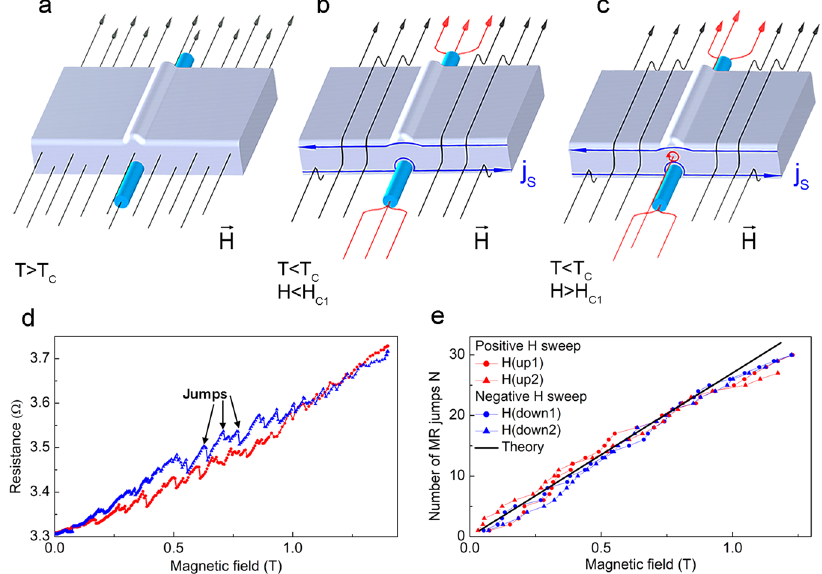
Figure 2. Device behavior at different external magnetic fields and temperatures. ( a ) T > T C , the magnetic field (presented by a series of black arrows) uniformly enters the sample. There is no screening current. ( b ) T < T C , at H c < H < H c 1 the magnetic field is expelled owing to screening Meissner currents (blue arrows) flowing along the edges of Nb-electrodes; it is focused in the nanowire. The screening current flow is strongly modified near Nb/Ni-interface. ( c ) An Abrikosov vortex penetrates inside Nb-electrode from Nb/Ni interface. ( d ) Enlarged picture of resistance jumps, marked by arrows, on R ( H ) dependence at T = 4.2 K, these jumps are almost equidistant. ( e ) Statistics of the magneto-resistance jumps visible in Figs 1d and 2d as a function of the applied field changing in different sweep